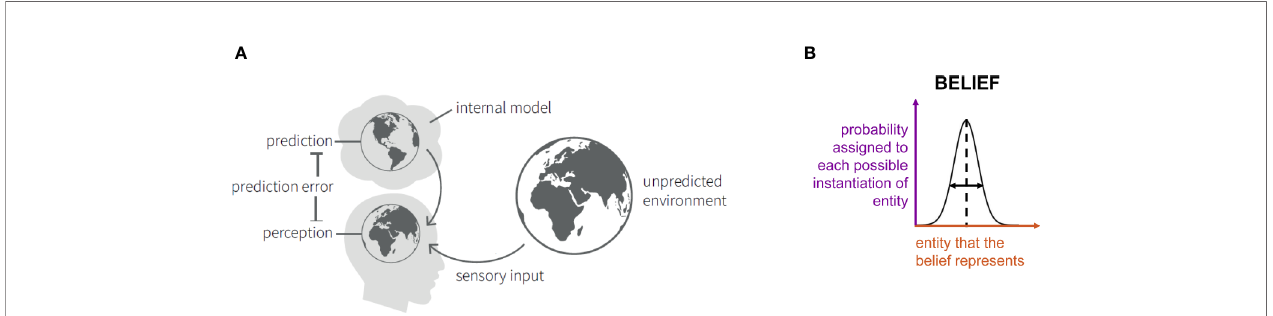
FIGURE 1 | (A) Schematic summary of the “ Bayesian brain ” notion that the brain contains an internal model consisting of beliefs about the states of the environment. These give rise to predictions about sensory inputs. The discrepancy between the actual and the predicted sensory inputs (prediction error) serves to update the model. Adapted from Figure 3 in Haker et al. (82), with permission. (B) An illustration of the concept of “ beliefs ” as probability distributions. Here, we consider Gaussian probability distributions (or, more precisely, densities) that are characterized by an expectation (or mean; represented by the vertical dashed line) and precision (inverse variance; symbolized by the horizontal double arrow). The x-axis (red) indicates the entity that the belief represents (e.g. the temperature of a particular object). The y-axis (violet) represents, simply speaking, the probability that is assigned to each possible instantiation of this entity (in the above example: the probability that object temperature has a